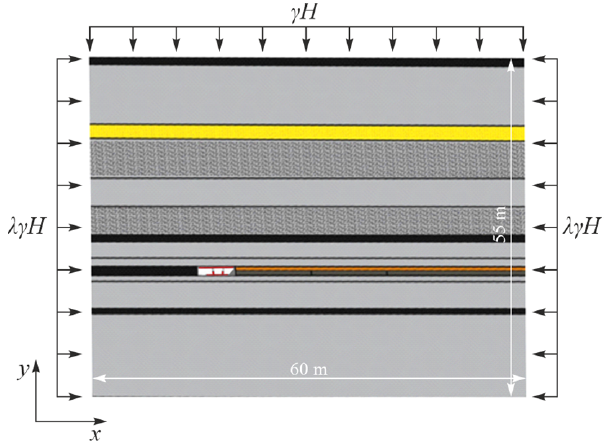
Figure 3. Calculation scheme for geomechanical assessment of the state of coal-bearing mass around the longwall face.